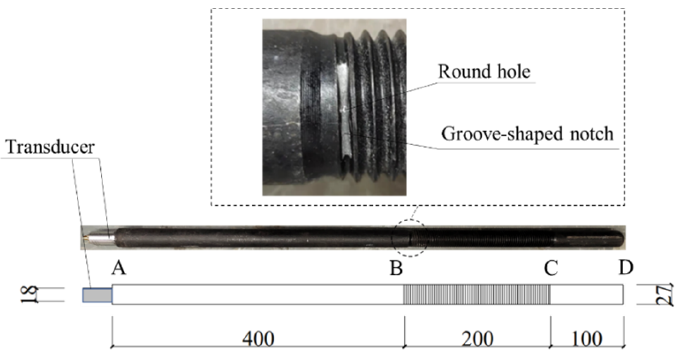
Figure 20. Geometry of specimen.